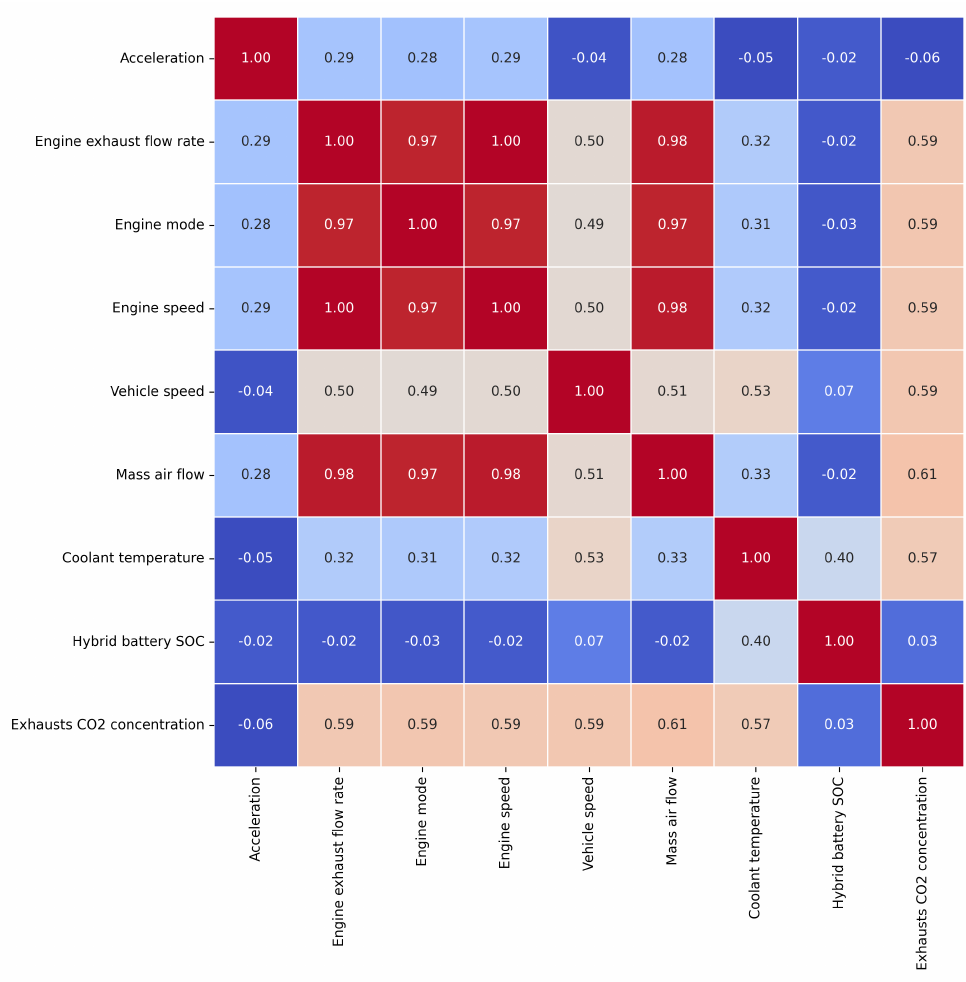
Figure 3. Correlation matrix composed of the final input values